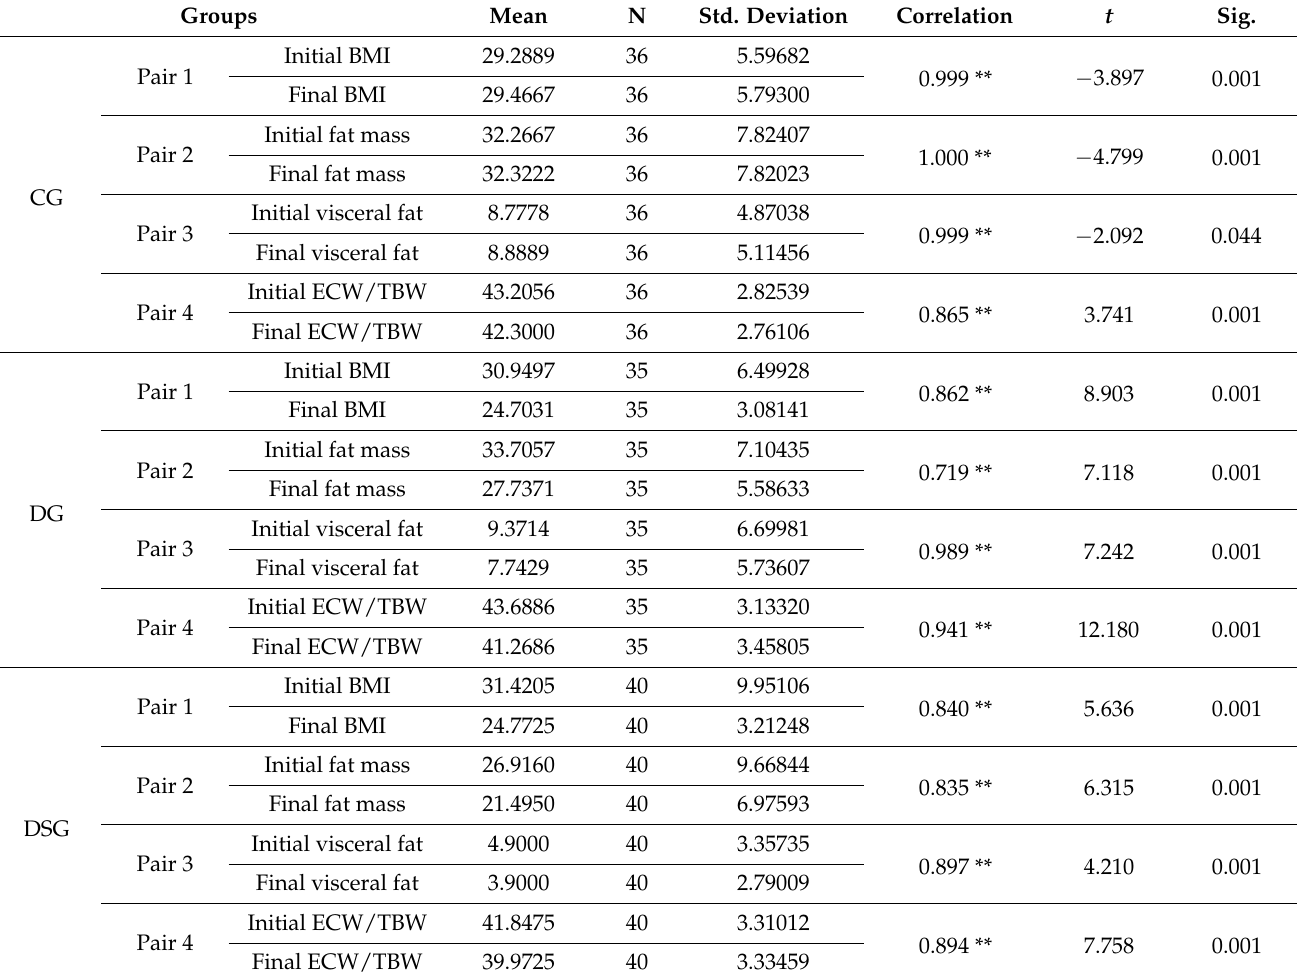
Table 3. Statistical evaluation of research parameters compared final results with initial values in all three research groups. Groups Mean N Std. Deviation